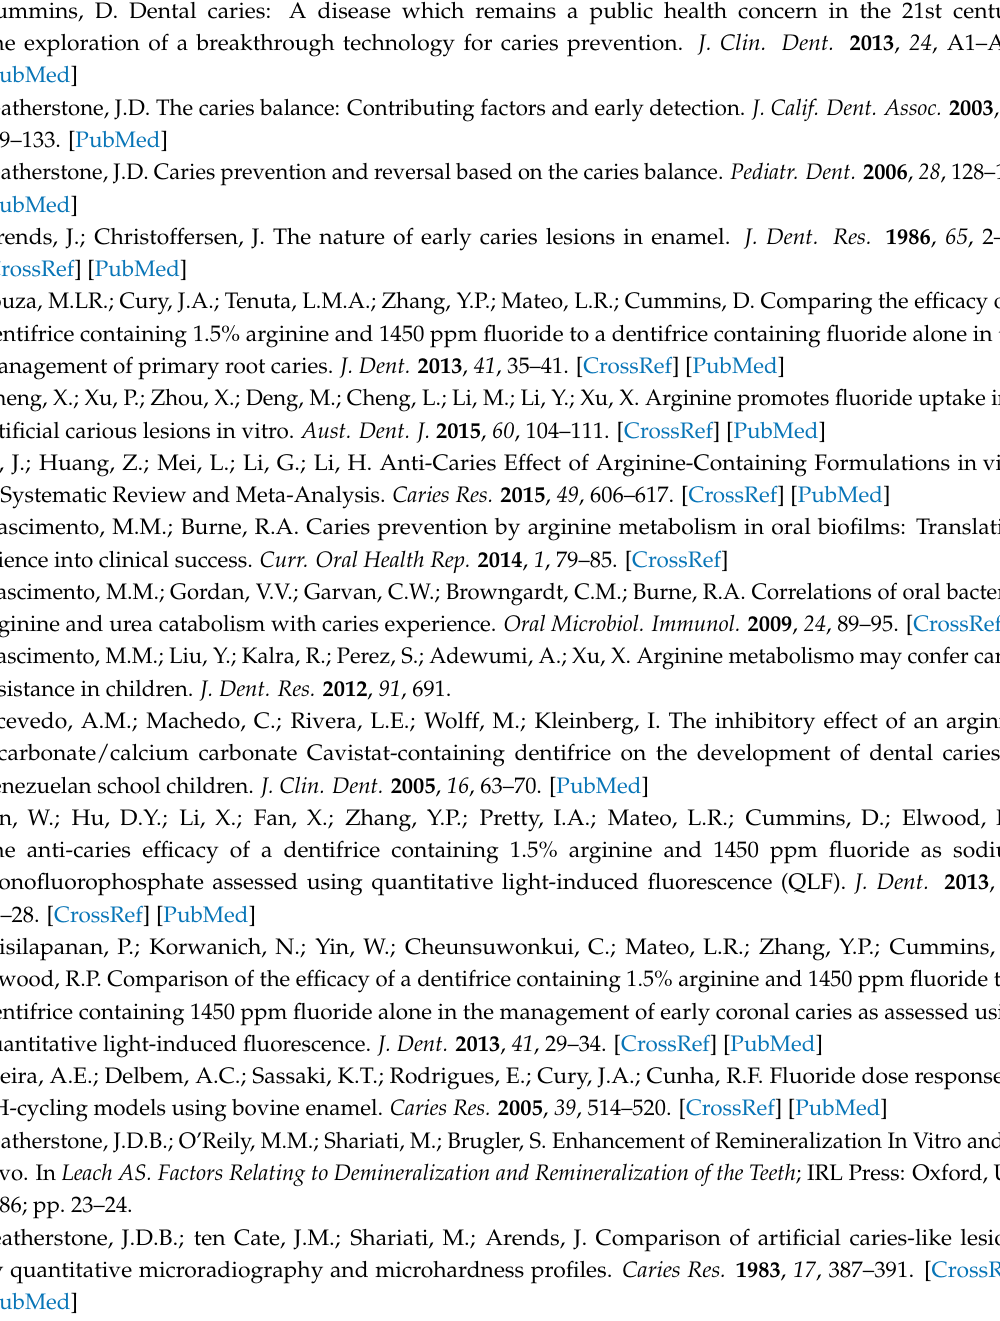
The microhardness indentation of caries lesion bovine dental enamel treated with non-fluoride dentifrice This microscopic image was captured in a microhardness program (40 × ). Figure S7. The microhardness indentation of caries lesion bovine dental enamel treated with Neutraçucar This microscopic image was captured in a microhardness program (40 ×